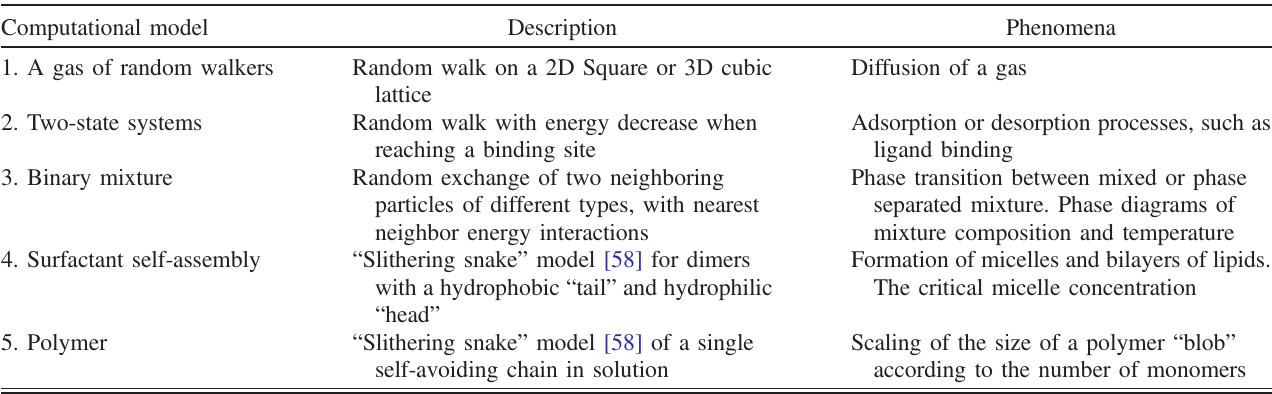
TABLE I. The fundamental computational models that were studied in the redesigned course. Computational